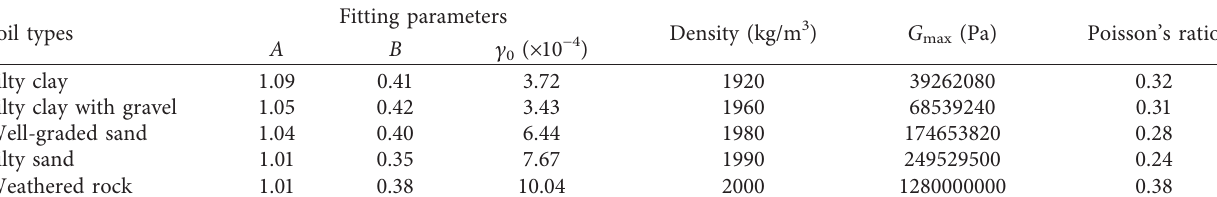
Figure 4: The waveform, significant duration, Fourier spectra, and response spectra of selected earthquake records: (a) time history and significant duration of Shizuoka wave; (b) time history and significant duration of Tochigi wave; (c) Fourier and response spectra of Shizuoka wave; (d) Fourier and response spectra of Tochigi wave. Table 2: Soil